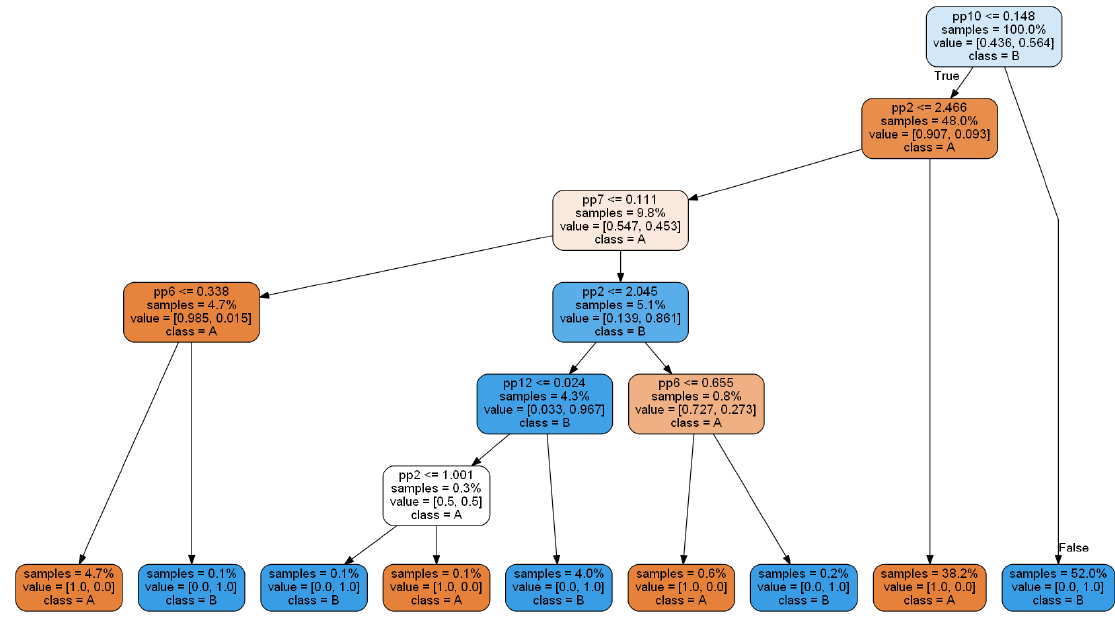
Figure 7. CART-E decision